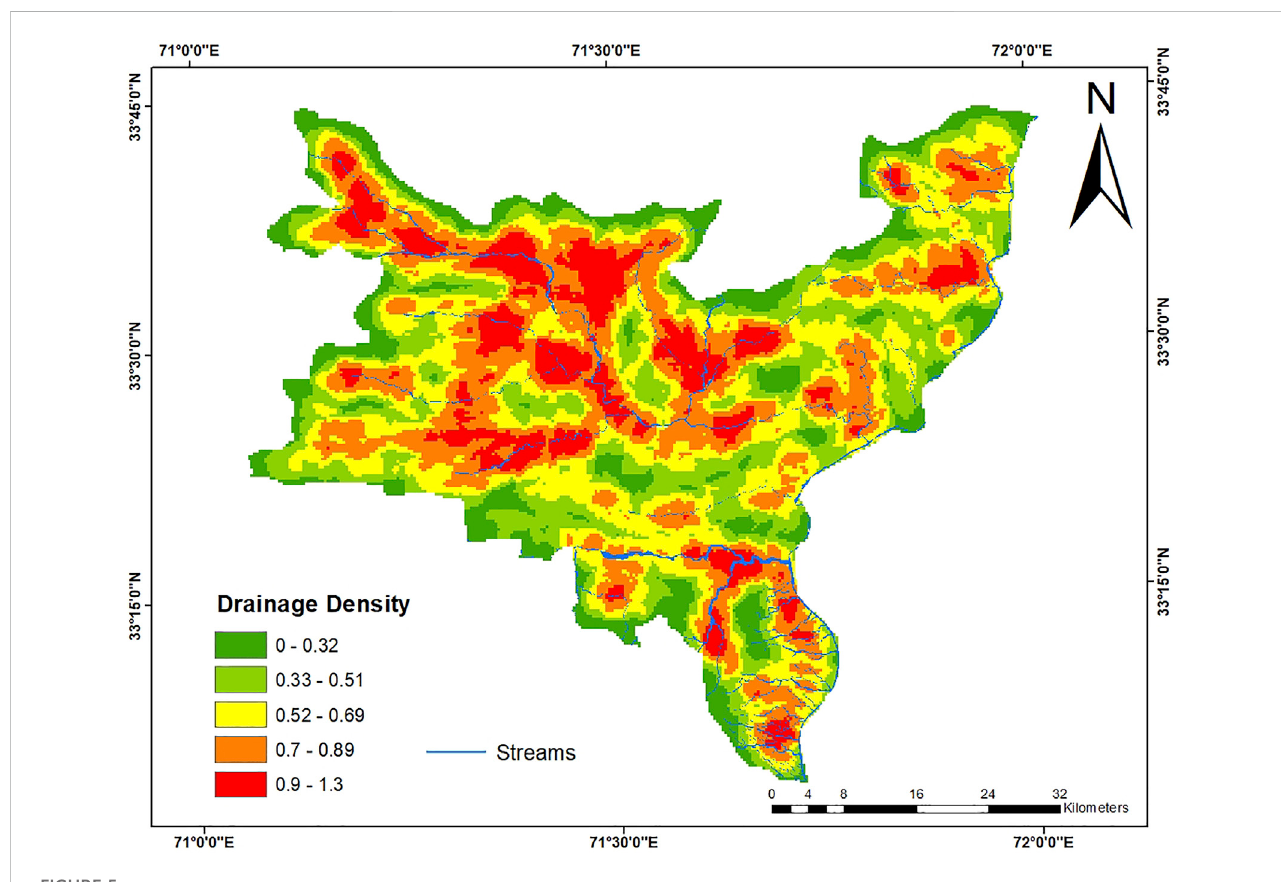
FIGURE 5 Drainage density map of the study